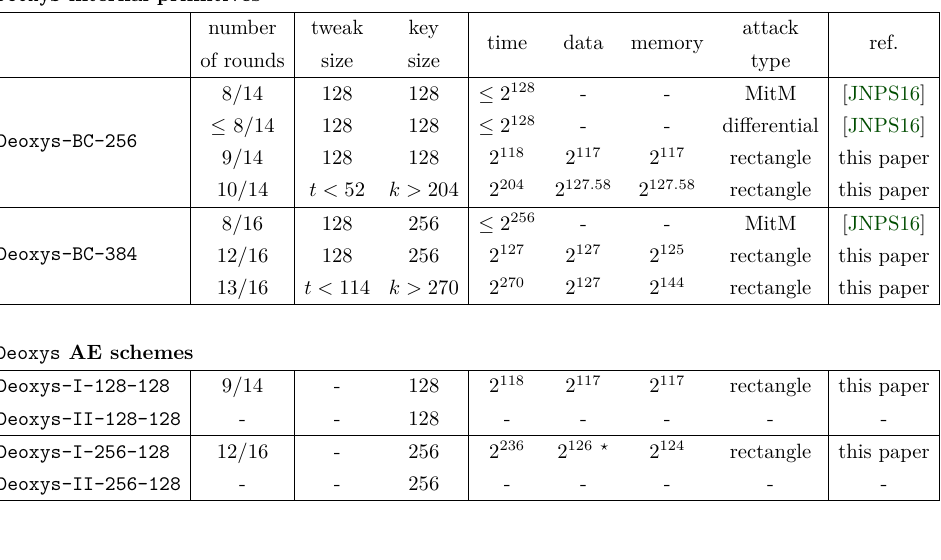
Table 2: Previous and new cryptanalysis results on Deoxys-BC-256 and Deoxys-BC-384 (top table, Section 4), as well as on the four Deoxys CAESAR candidates Deoxys-I-128-128 , Deoxys-II-128-128 , Deoxys-I-256-128 and Deoxys-II-256-128 (bottom table, Section 6). The attack marked with ( ? ) has a success probability of about 75% compared to about 95% for the other